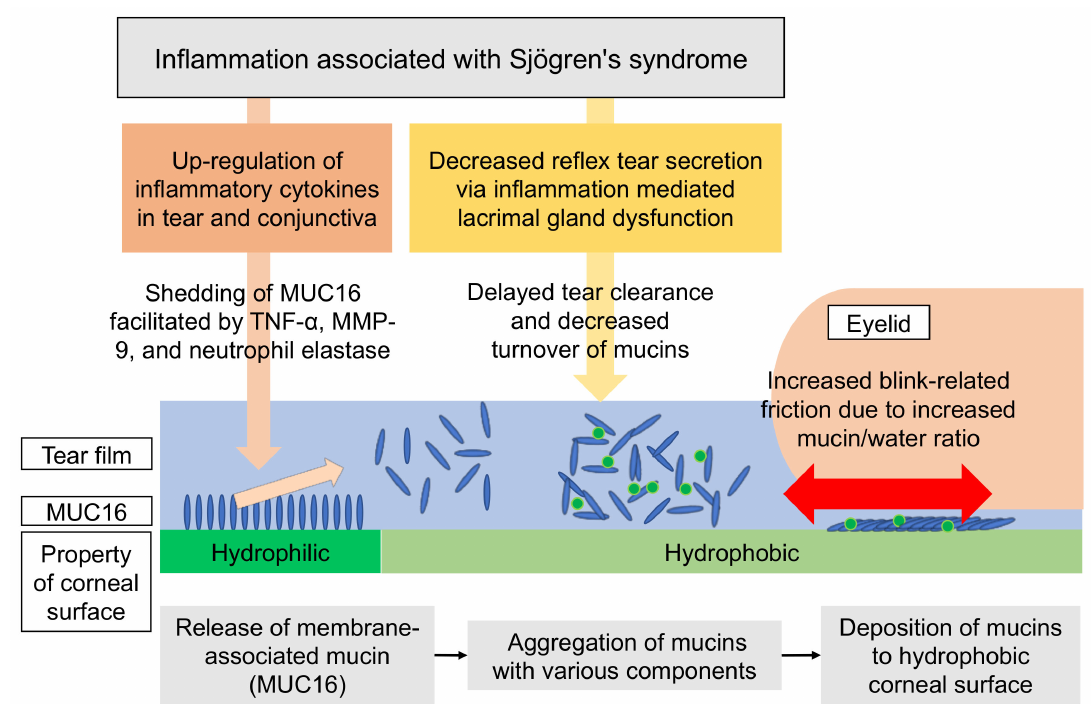
Figure 4. Proposed mechanism in PPCS. Inflammation associated with Sjögren’s syndrome (SS) results in the production of inflammatory cytokines in tears and the conjunctiva. As a result, those cytokines, including TNF- α , MMP-9, and neutrophil elastase, may cause the shedding of mucin MUC16 from the ocular surface epithelium, thus leading to the accumulation of the mucin components in tears. This accumulation of mucins in tears is accelerated by delayed tear clearance associated with aqueous tear deficiency (ATD) commonly seen in SS. On the other hand, the physical property of the corneal surface is likely to change from hydrophilic to hydrophobic due to the decrease in MUC16 via shedding, which may lead to the deposition of mucins to the corneal surface. This mechanism may also be enhanced by the increased blink-related friction associated with